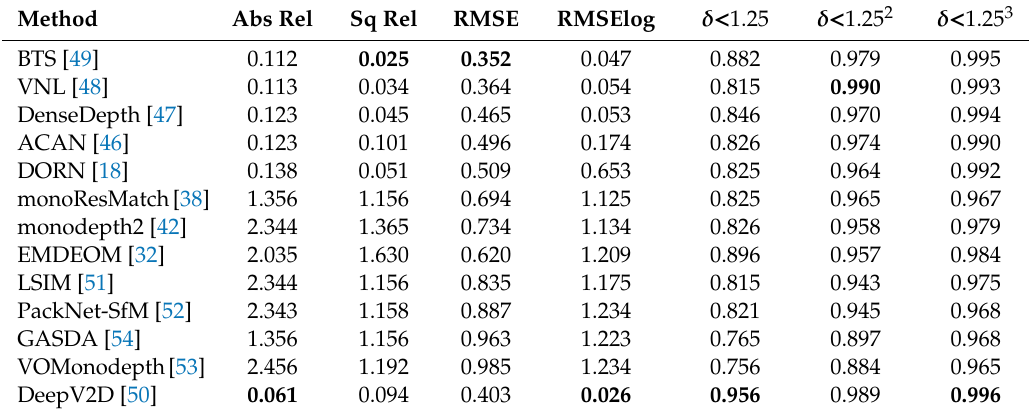
Table 5. Evaluation results on NYU-v2 dataset. Best method per metric is emboldened and highlighted in